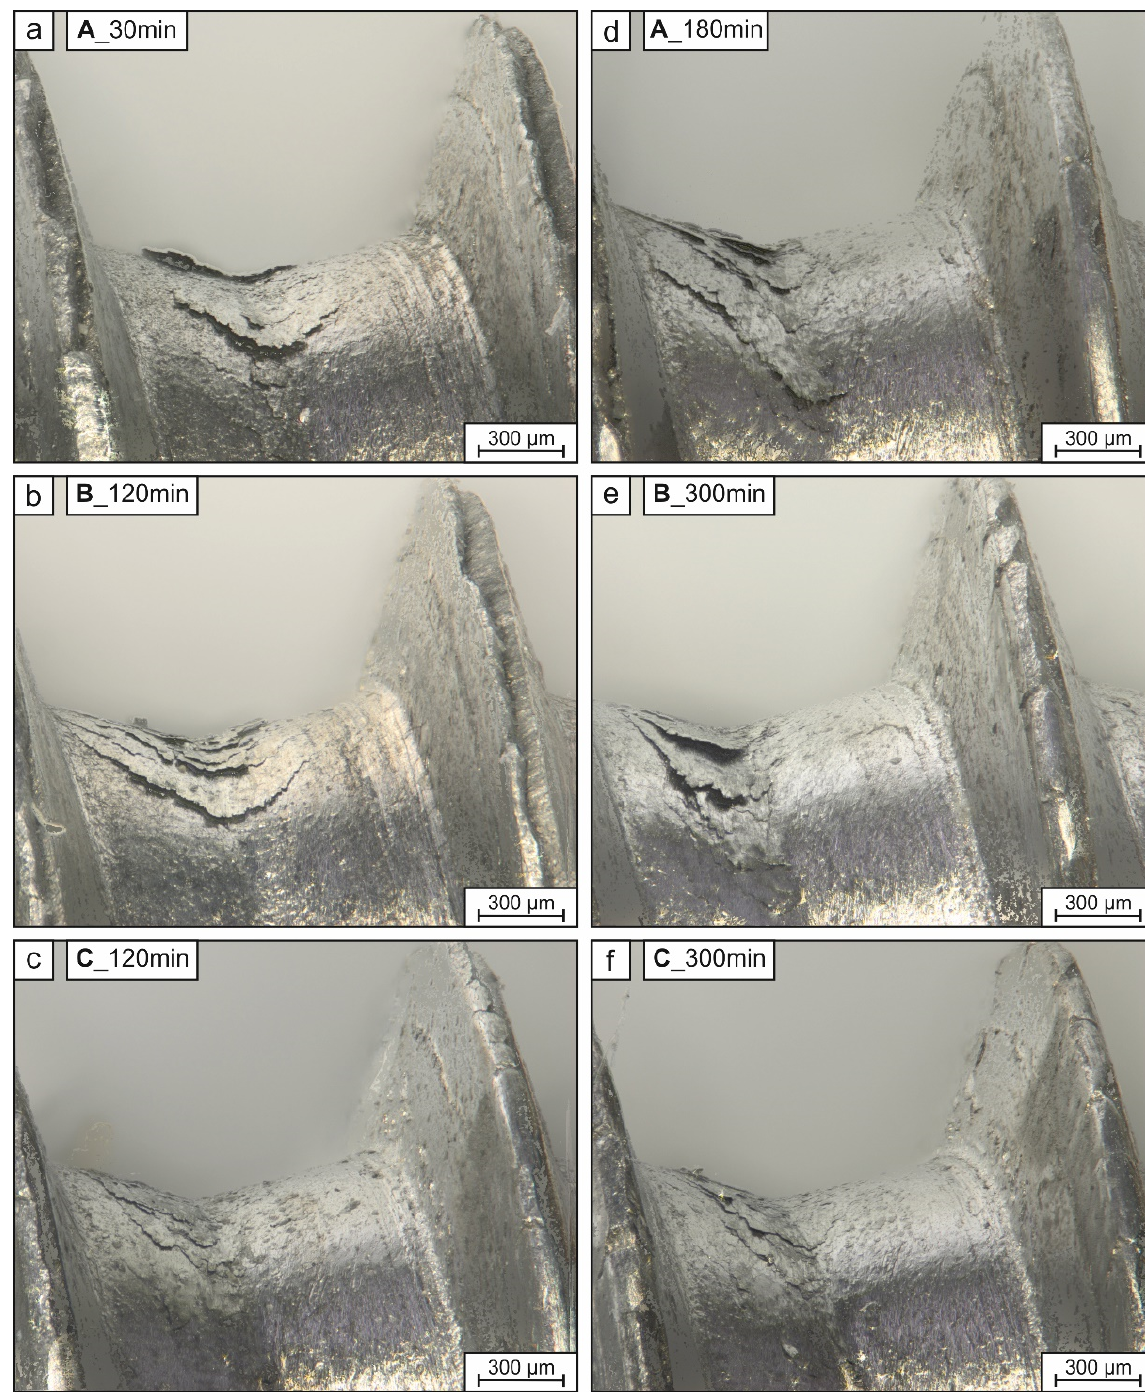
Figure 8. Stereo micrographs of the different processed and thread rolled parts. Processing route and initial heat treatment: ( a , b ) processing route A (initially solution-annealed), ( c , d ) processing route B (initially naturally aged), ( e , f ) processing route C (initially pre-aged). Artificial aging time: ( a – c ) local hardness maximum and ( d – f ) global peak-hardness achieved. All thread rolled studs show scaling at the thread root, but this effect is significantly less pronounced for the studs processed by route C, when compared to the other processing routes.